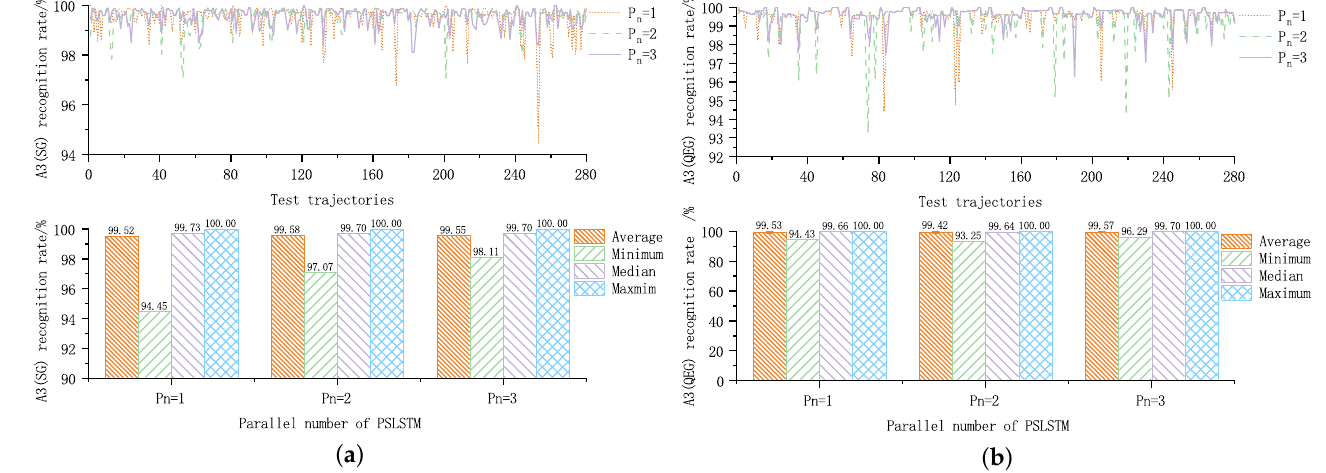
Figure 9. Recognition error of A3: ( a ) is the A3 ( SG ) recognition error curve and ( b ) is the A3 ( QEG ) recognition error